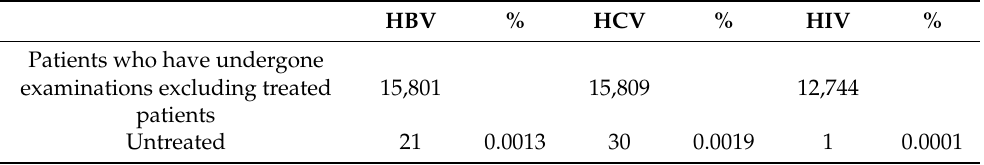
HBV; hepatitis B virus, HCV; hepatitis C virus, HIV; human immunodeficiency virus.